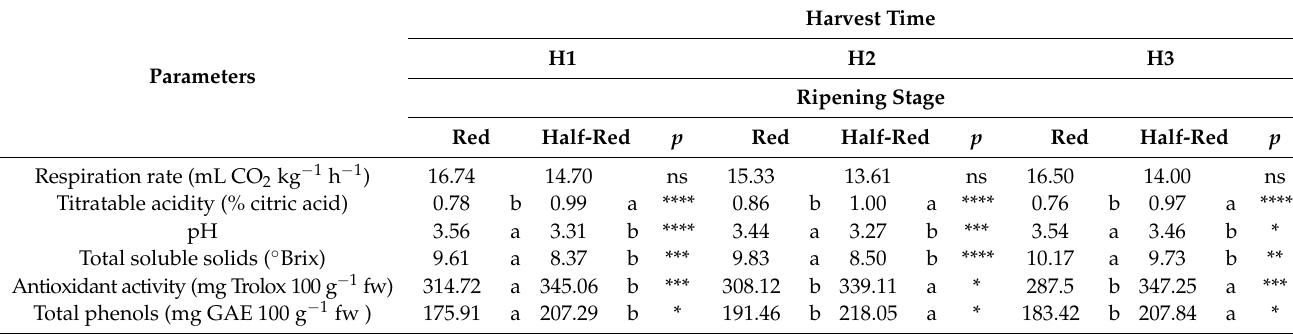
For each parameter the mean values followed by different letters (a, b) are significantly different ( p ≤ 0.05) according to least significant difference (LSD) test. Significance: ns = not significant; **** significant for p ≤ 0.0001; *** significant for p ≤ 0.001; ** significant for p ≤ 0.01; * significant for p ≤ 0.05. GAE is Gallic Acid